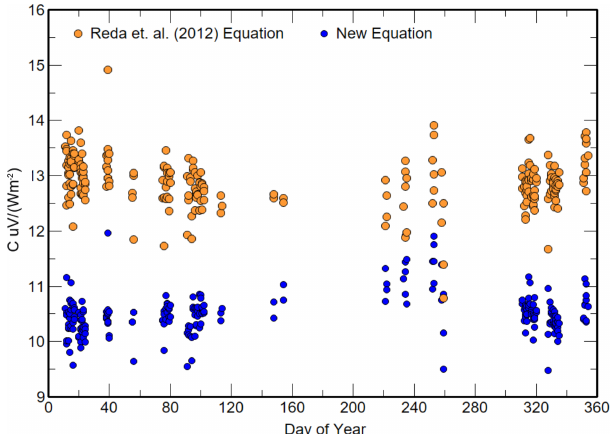
Figure 12. The derived C values derived from 244 linear LSQ cali- brations in 2020 for the Reda et al. (2012) and new equations using a concentrator emissivity of 0.0225 for both and a convection coef- ficient of 6.5 for the new equation.